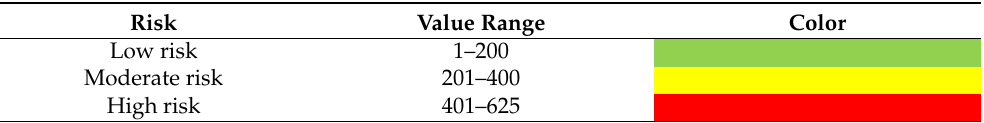
Table 6. Levels of risk (own